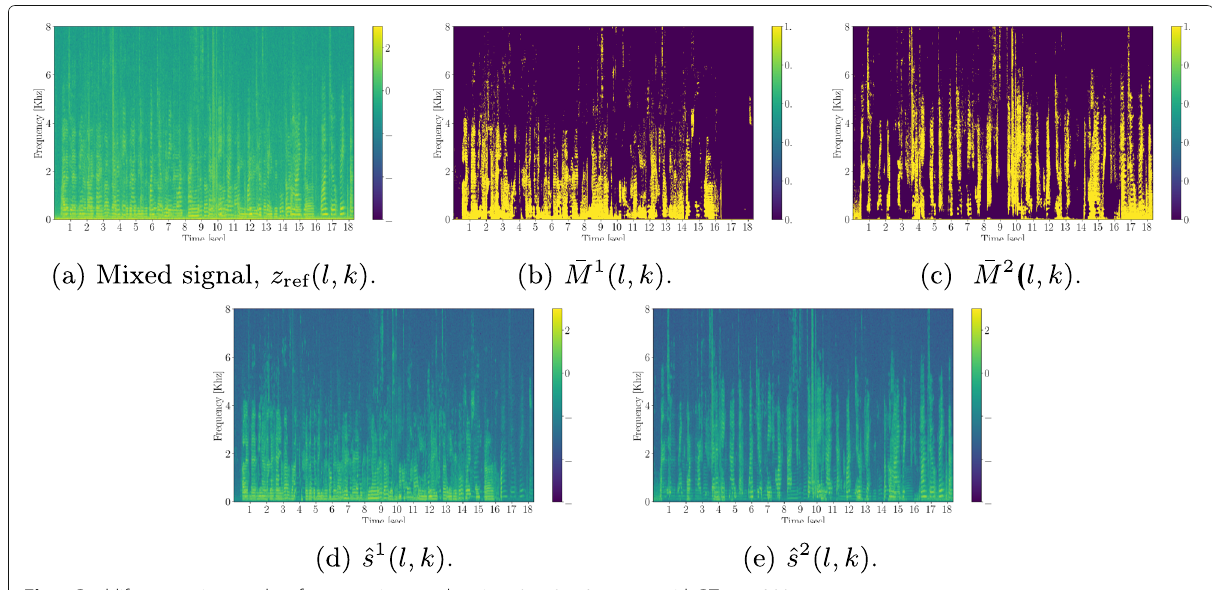
Fig. 5 Real-life separation results of two moving speakers in a 6 × 6 × 2.4 room with RT 60 = 390